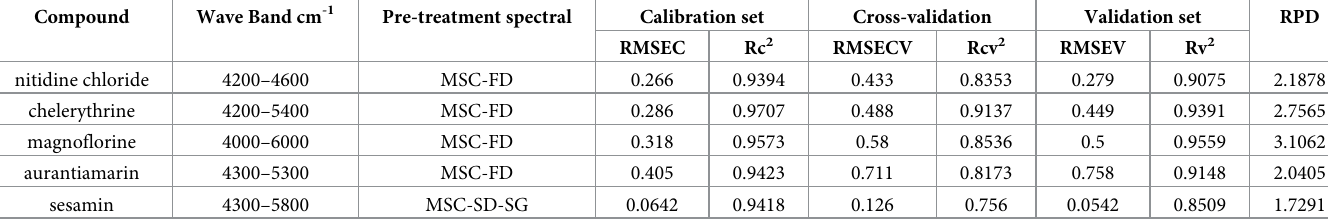
RMSEC: root mean square error of calibration, Rc 2 : correlation coefficient of determination in calibration, RMSECV: root mean square error of cross-validation, Rcv 2 : correlation coefficient of determination in cross-validation, RMSEV: root mean square error of validation, Rv 2 : correlation coefficient of determination in validation, and RPD: ratio of validation to deviation.